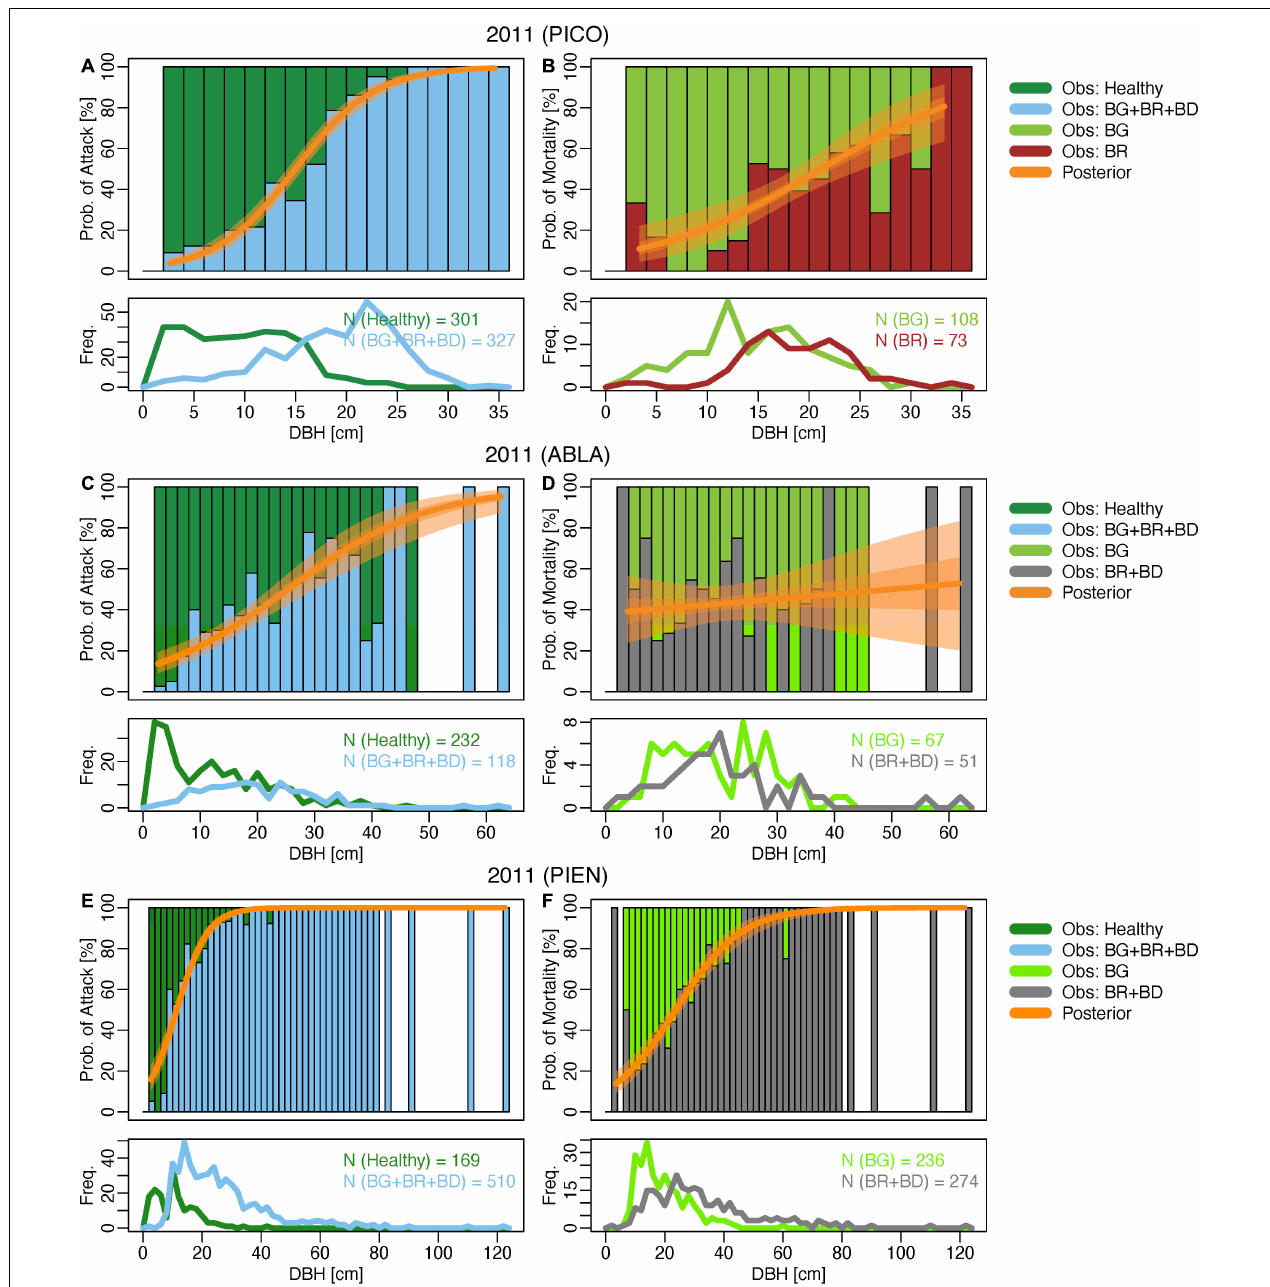
FIGURE 3 | Comparison of observed data (bars) and posterior probabilities (line) for all three species in the last epidemic year (2011). The orange line indicates the posterior median, the bands the 50% (darker) and 94% (lighter) credible intervals. Bars represent proportions of trees by status in bins corresponding to 2 cm diameter at breast height (DBH) increments. Bar coloration indicates status: healthy (green foliage, no signs of beetle activity), BG (beetle-green; green foliage, clear signs of beetle activity), BR (beetle-red; foliage red, clear signs of beetle activity), BD (beetle-dead; foliage missing, clear signs of beetle activity). See Supplementary Material for additional plots. PICO: lodgepole pine (A,B) ; ABLA: subalpine fir (C,D) ; PIEN: Engelmann spruce (E,F) . For lodgepole pine, we show observed and predicted probabilities for year-to-year (BR)